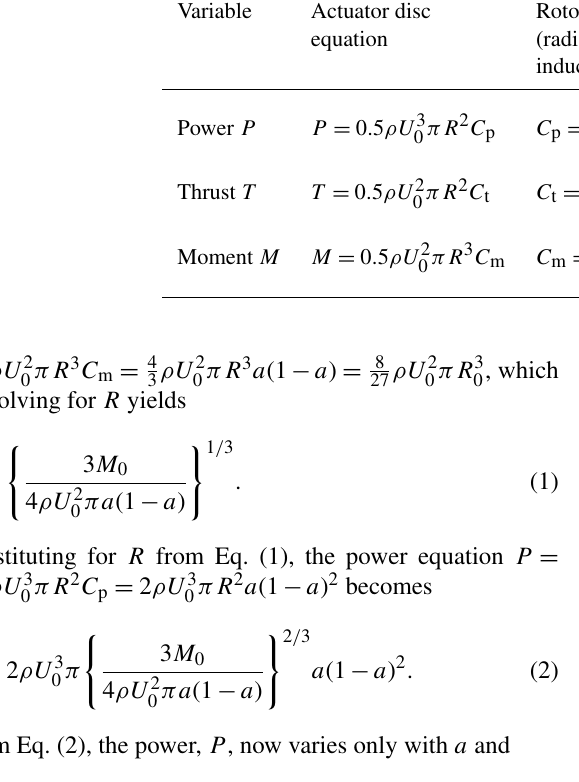
Figure 1. Design parameters related to axial